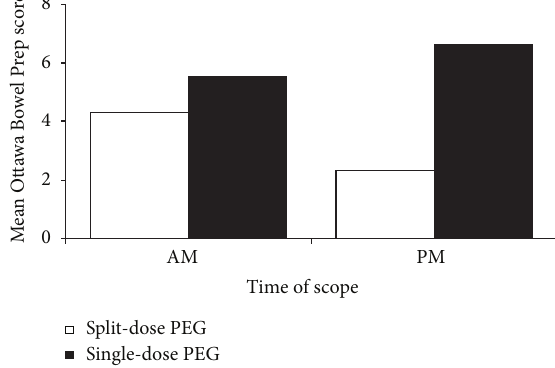
Figure 3: Bowel preparation quality for AM (earlier than 10:00 AM) and PM (after 10:00 AM) procedures. All single-dose patients took their bowel preparation (4L PEG) the day before the colonoscopy starting at noon for AM procedures and 6:00 PM for PM proce- dures. Split-dose patients took the second dose the evening before colonoscopy for AM procedures, or 5 hours before the colonoscopy time for PM